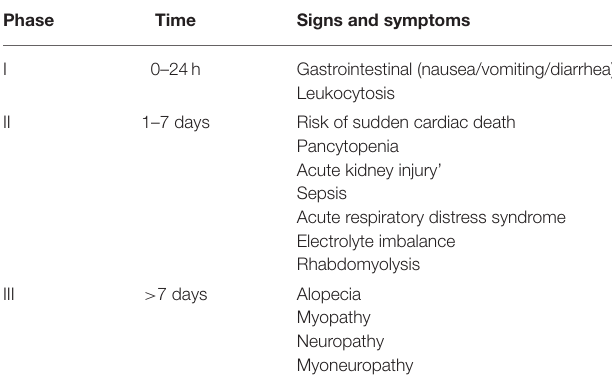
TABLE 7 | General involvements of different organ systems in colchicine poisoning (phases of colchicine